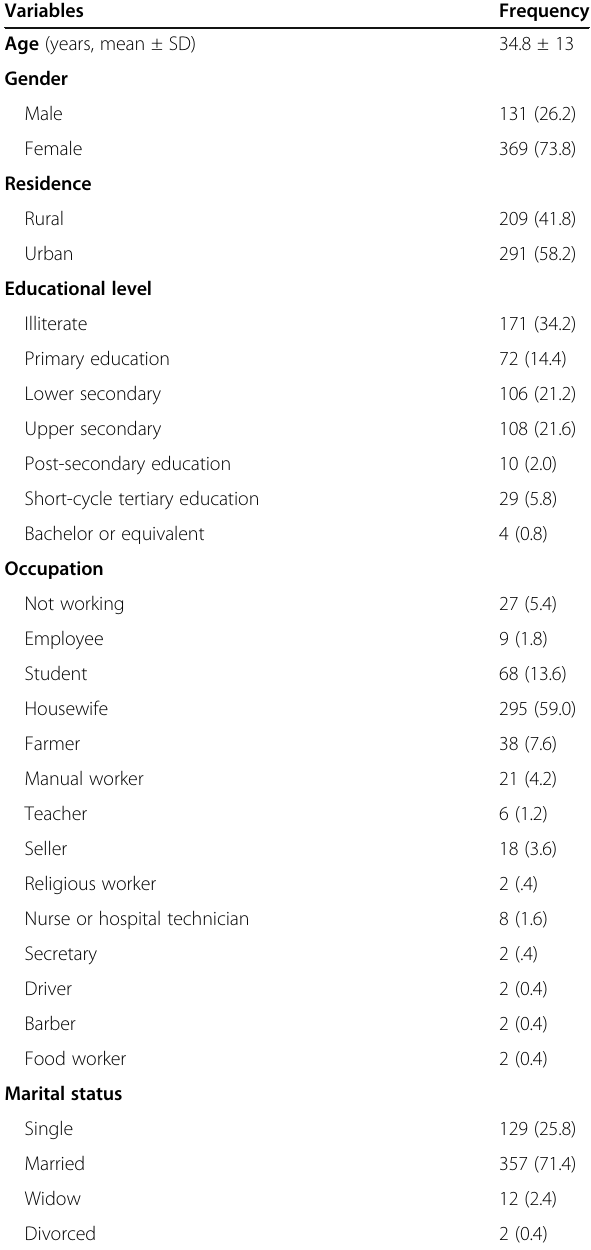
Table 1 Socio-demographic characteristics of the participants